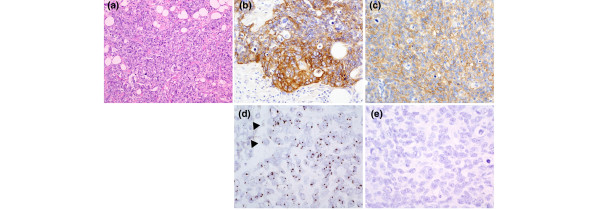
EGFR and HER2 overexpression and gene amplification in a spindle cell carcinoma. (a) Photomicrograph of a spindle cell carcinoma (haematoxylin and eosin). Immunohistochemical analysis revealed (b) EGFR grade 3+ positivity and (c) HER2 grade 2+ reactivity. (d) CISH demonstrating EGFR amplification (clusters of signals in the nuclei of neoplastic cells). Note the presence of one or two copies of EGFR in stromal cells (arrowheads). (e) CISH for HER2 gene: no amplification (2–3 gene copies/nucleus). CISH, chromogenic in situ hybridization; EGFR, epidermal growth factor receptor; HER, human epidermal growth factor receptor; MBC, metaplastic breast carcinoma.